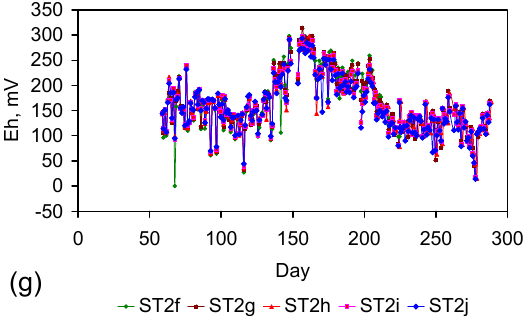
Figure C6. ( a ) pH vs. Eh; ( b ) EC vs. day, ST2a–ST2e; ( c) EC vs. day, ST2f–ST2j; ( d ) pH vs. day, ST2a–ST2e; ( e ) pH vs. day, ST2f–ST2j; ( f ) Eh vs. day, ST2a–ST2e; ( g ) Eh vs. day, ST2f–ST2j. ZVM TP = copper sheathed pellets (15 mm OD) placed in water at a concentration of ST2a = 28.5 g·L − 1 ; ST2b = 30 g·L − 1 ; ST2c = 25 g·L − 1 ; ST2d = 25 g·L − 1 ; ST2e = 33.5 g·L − 1 ; ST2f = 26.5 g·L − 1 ; ST2g = 26.5 g·L − 1 ; ST2h = 23.5 g·L − 1 ;